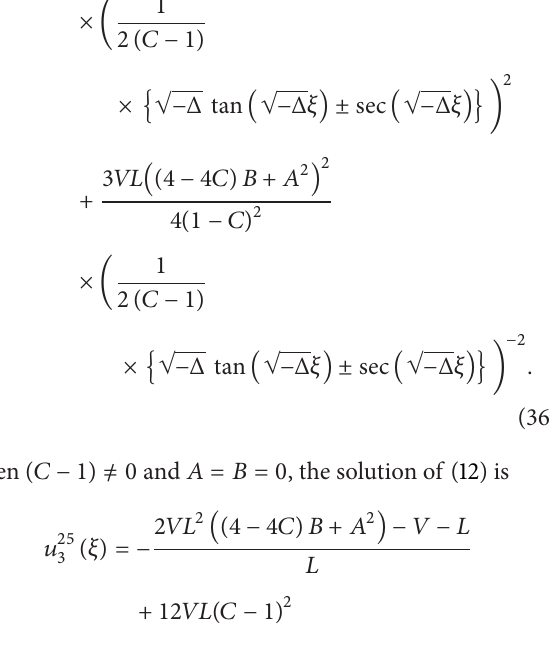
and its graph is given in Figure 4.